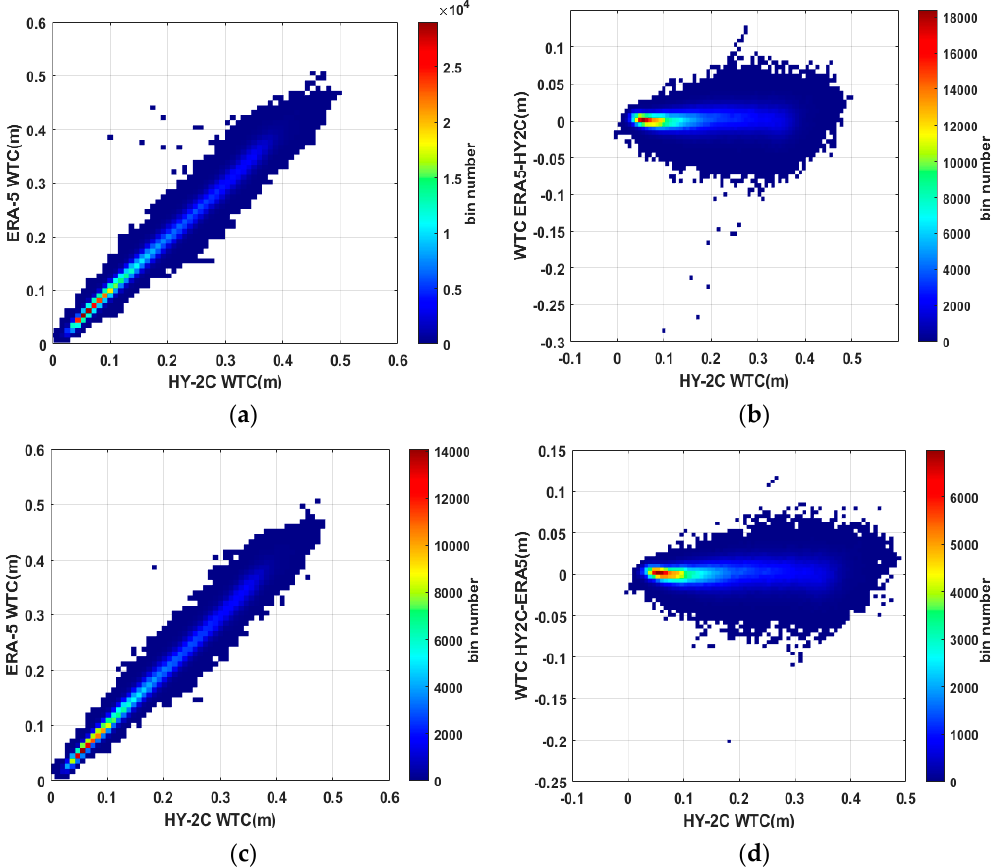
Figure 5. ( a ): HY-2C WTC versus ERA-5 WTC in algorithm database; ( b ): HY-2C WTC versus WTC difference between HY-2C and ERA-5 in algorithm database; ( c ): HY-2C WTC versus ERA-5 WTC in retrieval database; ( d ): HY-2C WTC versus WTC difference between HY-2C and ERA-5 in retrieval database.